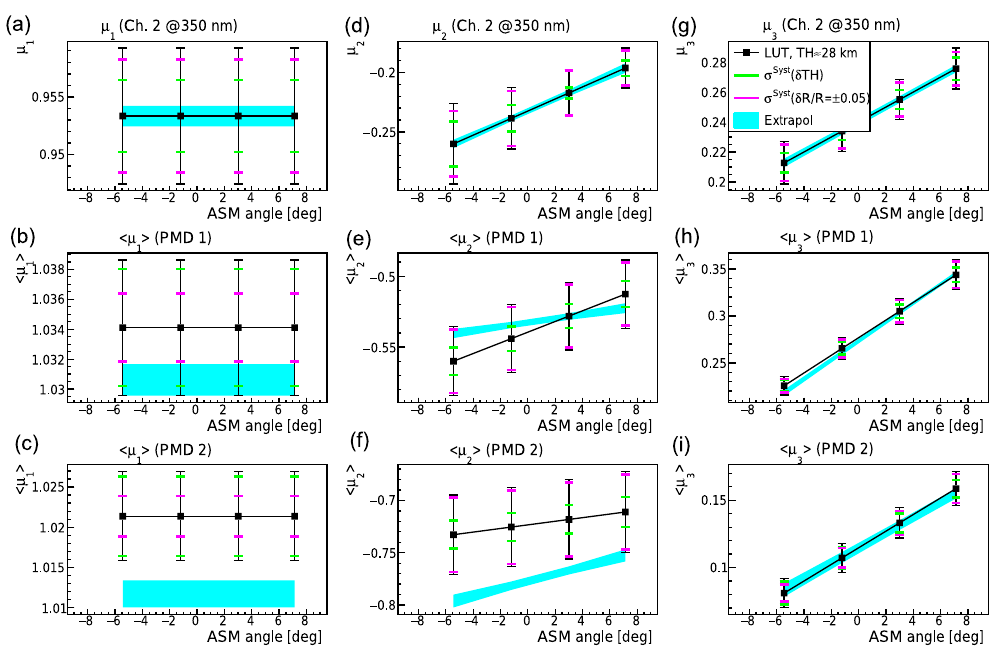
Figure 9. Final results vs. ASM angle for limb at a TH of 28km in 2004 from the LUT method (PMDs) and extrapolation method (channel 2). Rows: (a, d, g) channel 2 feature, (b, e, h) PMD 1, (c, f, i) PMD 2; columns: (a, b, c) (cid:104) µ 1 (cid:105) , (d, e, f) (cid:104) µ P data points are the results with total errors; magenta and green error bars indicate the contribution from each class of systematic errors. The light-blue band shows the result from the extrapolation method with statistical errors